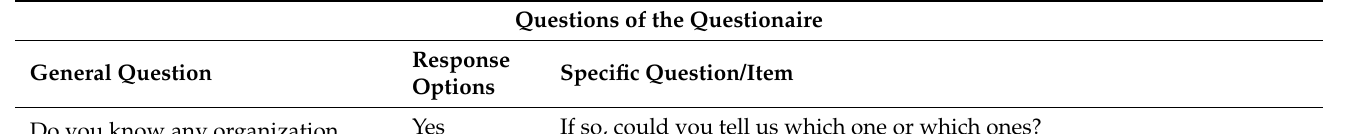
Table 1. Questions raised in the questionnaire and in discussion